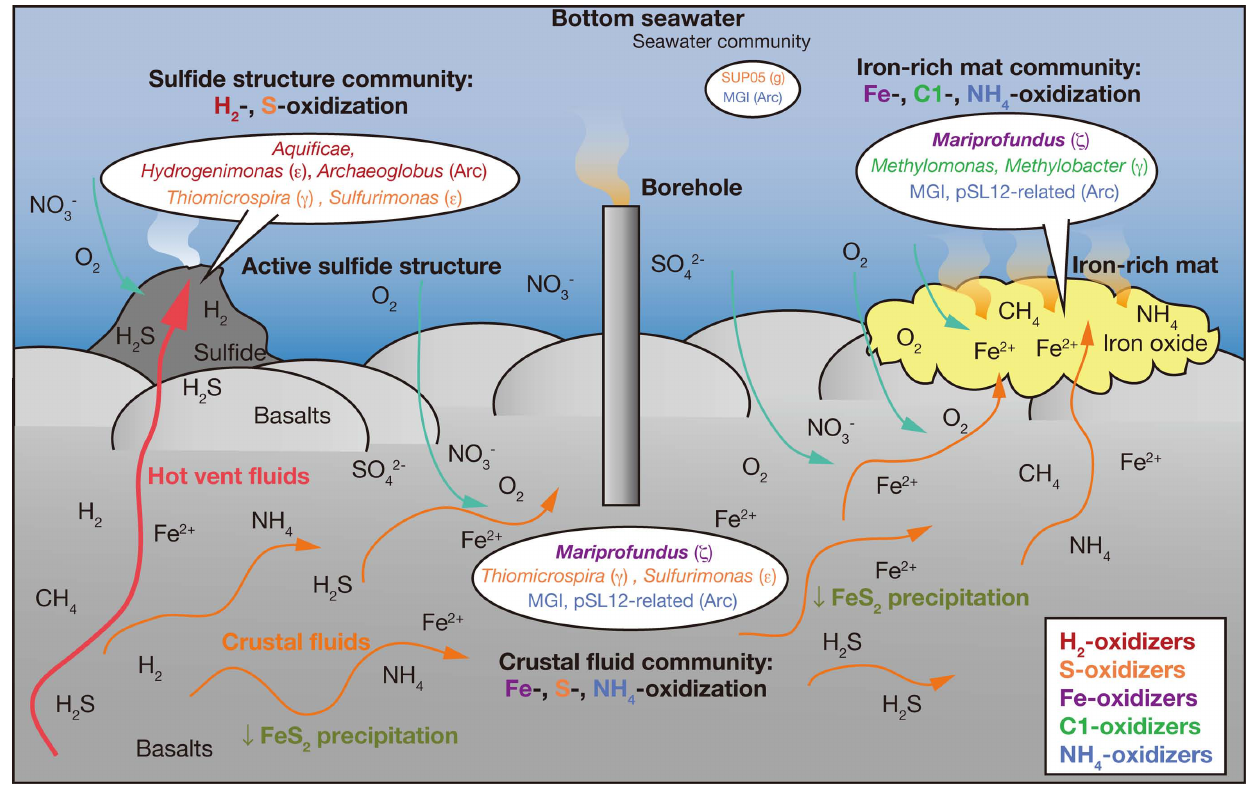
FIGURE 6 |A model for the appearance of the microbial community structures in each habitat in the SMT. This model is based on the microbiological and geochemical characteristics in the Snail site.